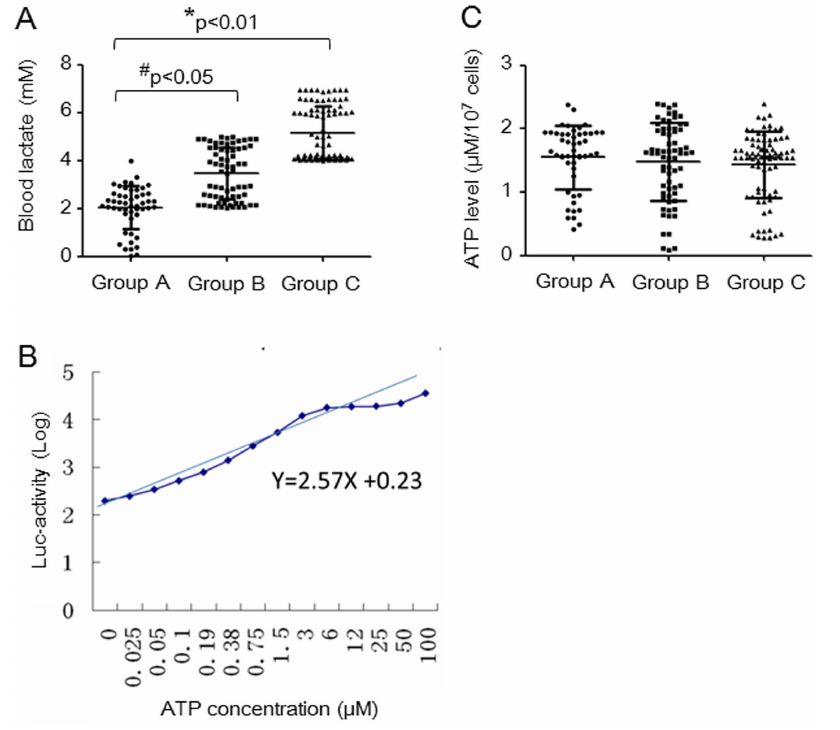
Figure 1. Plasma lactate and PBMC ATP levels among control and NRTI-treated children with AIDS. A: The concentration of plasma lactate in control children (Group A, n=50),children with AIDS treated for less than 36 months (Group B, n=68) and children with AIDS treated for 36 to 72 months (Group C, n=84); *P , 0.01, # p , 0.05. B: Linear relationship between the log of luciferase activity and ATP concentration. C: PBMC ATP levels in control children (Group A, n=50), children with AIDS treated for less than 36 months (Group B, n=68) and children with AIDS treated for 36 to 72 months (Group C, n=84). doi:10.1371/journal.pone.0057223.g001 PLOS ONE |